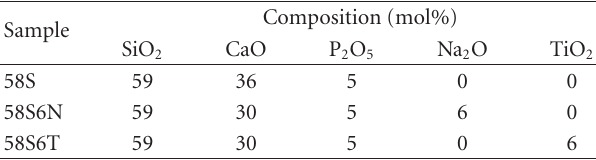
Table 1: Chemical composition of the synthesized bioactive glasses.